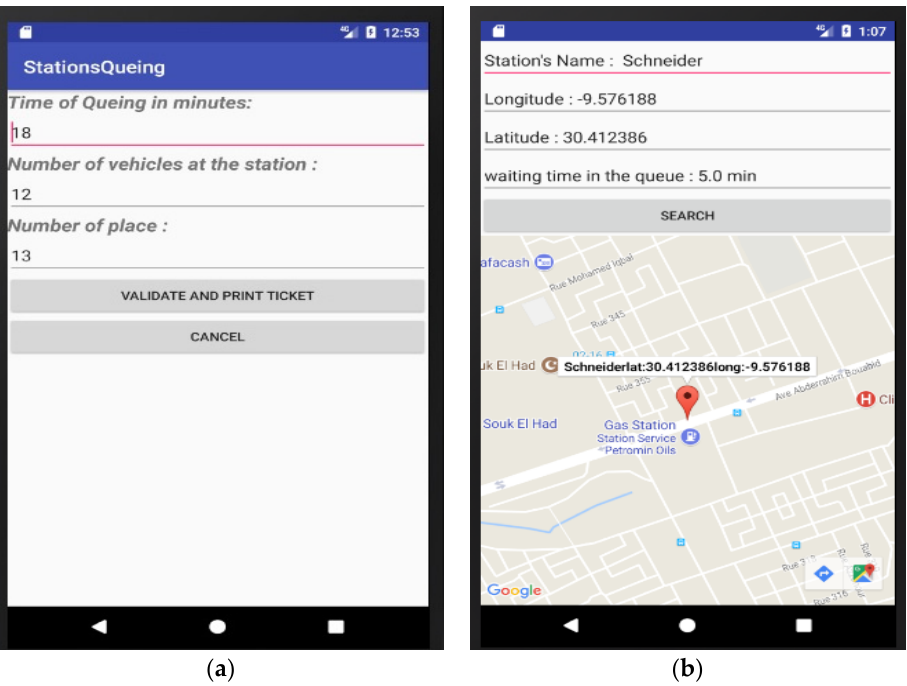
Figure 4. The mobile interface of: ( a ) EVPSS; ( b ) EV. Reproduced with permission from [12].